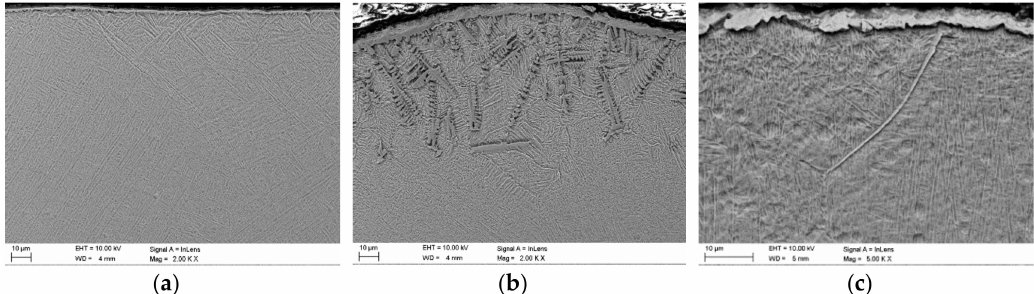
Figure 7. Scanning electron microscopy (SEM) micrographs at cross-sections in the near top surface region: ( a ) as-received titanium alloy Ti6Al4V sheet 3.0 mm thick (surface roughness Ra 0.4, thickness of the oxide surface layer approx. 1–2.5 µ m); ( b ) nitrided surface layer produced at a laser power of 1.8 kW and scanning speed of 400 mm / min on a substrate of titanium alloy Ti6Al4V (surface roughness Ra 8.2, thickness of the titanium nitrides surface layer approx. 2–5 µ m); ( c ) titanium alloy Ti6Al4V sheet 3.0 mm thick oxidized at 900 ◦ C in pure air for 10 min (surface roughness Ra 25, thickness of the oxide